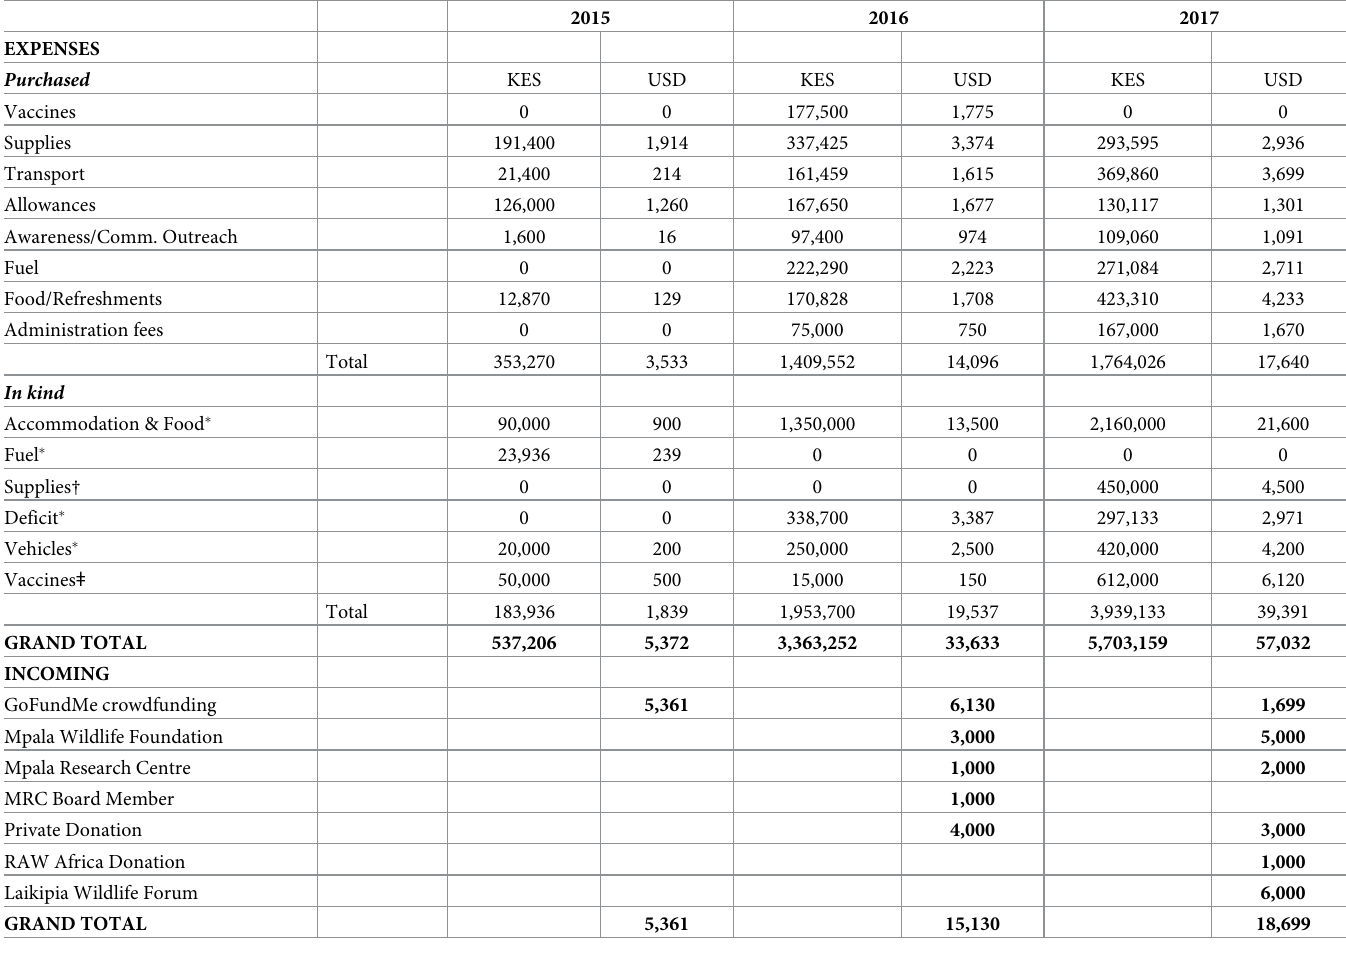
Table 2. Financial summary for the Laikipia Rabies Vaccination Campaign for